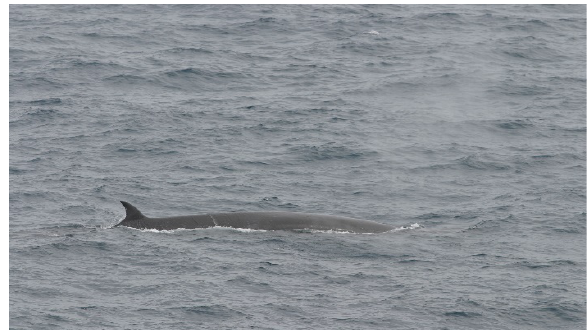
Figure 7. Sei whale. Photo credit: Gísli Víkingsson, Marine and Freshwater Research Institute, Iceland. Estimates of the abundance of sei whales have been